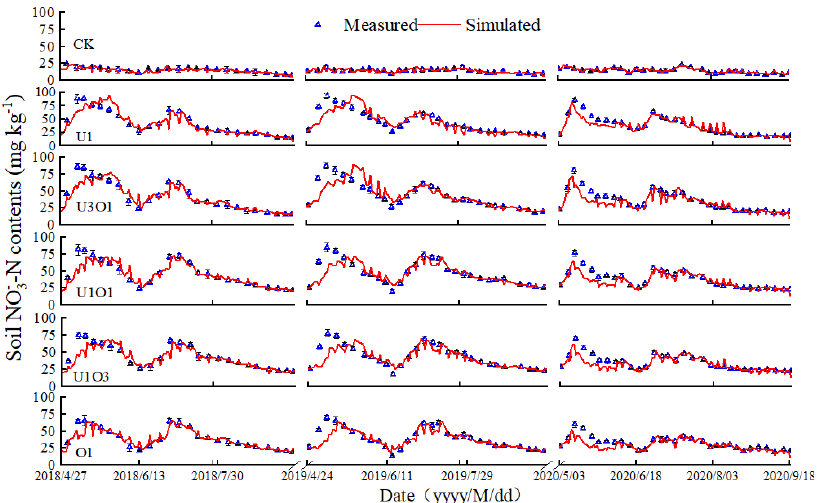
Figure 2. The modeled and measured grain yield under different treatments. Bars are the standard deviation of the measured values. Different small letters indicate significant differences ( p < 0.05) between treatments.